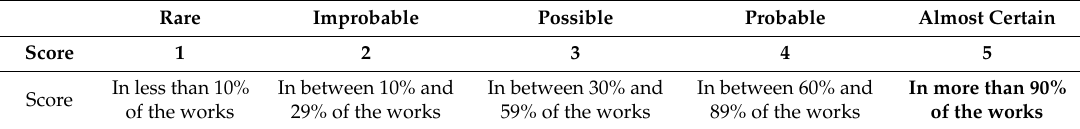
Table 5. Scale of occurrence of